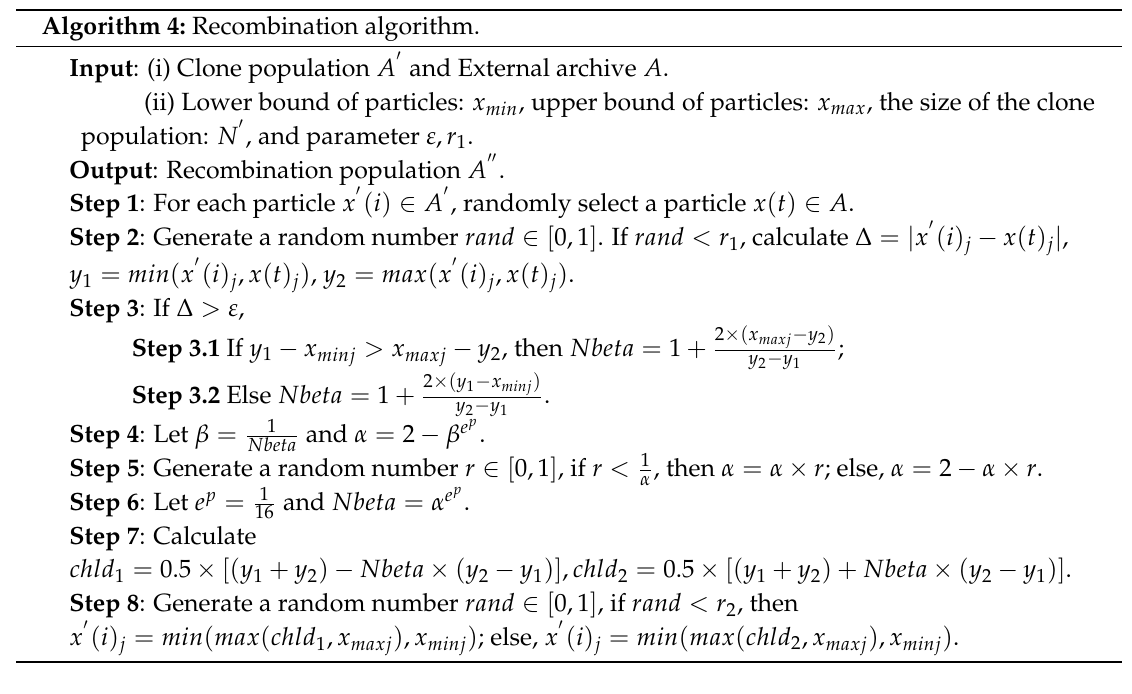
Algorithm 4: Recombination